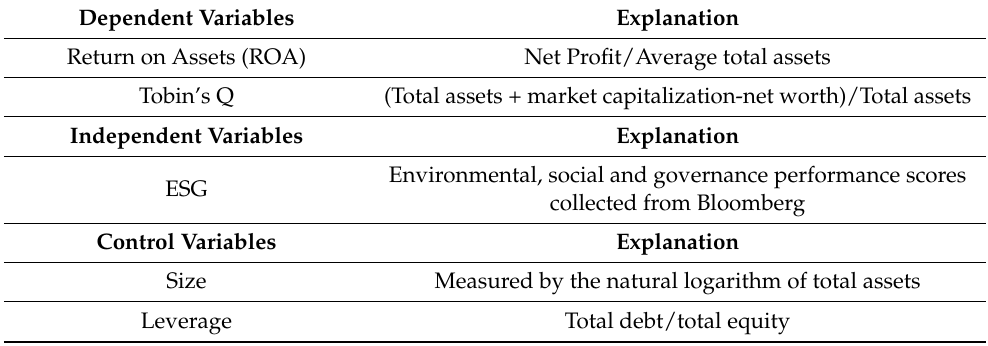
Table 6. Variables of the